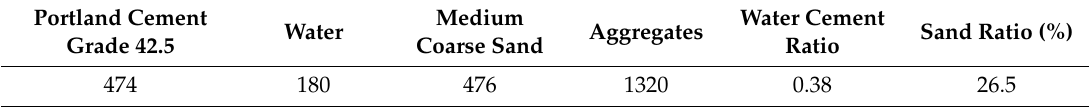
Table 1. Concrete mix design (kg/m 3 ).